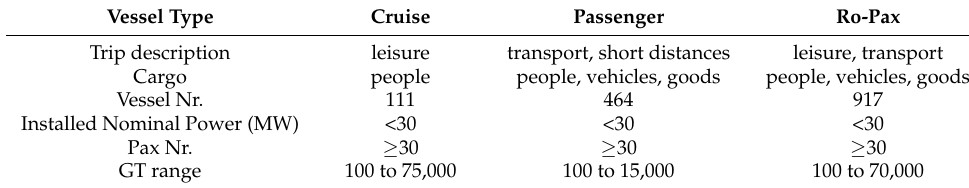
Table 1. Database